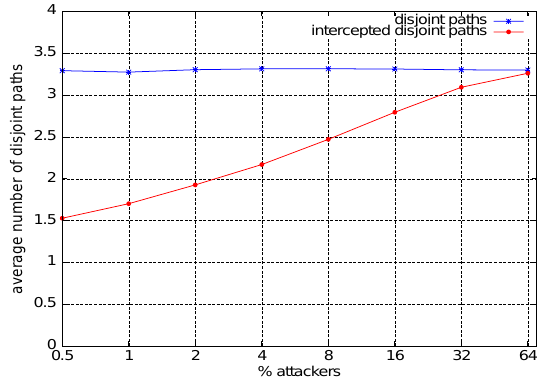
Figure 11. Average number of disjoint paths (total and intercepted) per source-destination pair in the IPv4 12.9k-node